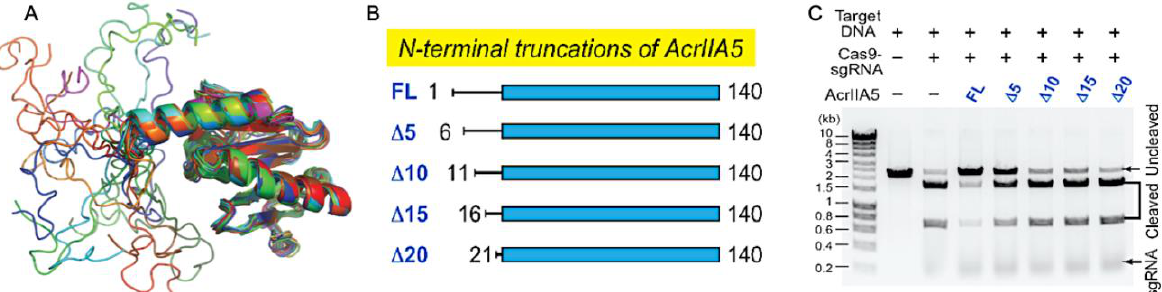
Figure 2. Steric occlusion of nucleic acids by Acrs. ( A ) Superimposed ensemble of 20 NMR structures of AcrIIA5 demonstrating N-terminal disorder preceding a highly structured domain. ( B ) Engineered constructs of AcrIIA5 with N-terminal IDR truncations. ( C ) Functional impact of IDR truncations on the inhibitory activity of AcrIIA5 against Cas9. DNA cleavage assays demonstrate that AcrIIA5 is incapable of arresting Cas9 cleavage function in the absence of its N-terminal IDR. Figure 2A–C is reprinted/adapted from An, S. Y. et al. Intrinsic disorder is essential for Cas9 inhibition of anti- CRISPR AcrIIA5